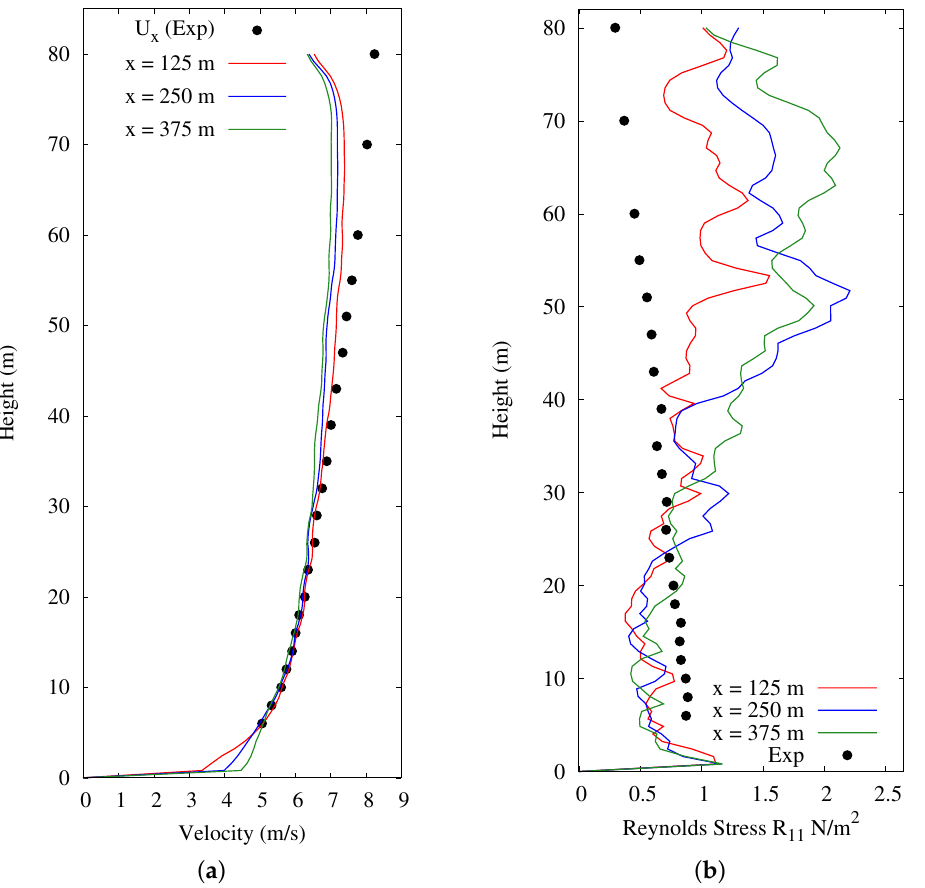
Figure 12. Development of the vertical profiles of ( a ) velocity, and ( b ) Reynolds stress R 11 at four different locations along the domain in x-direction. Colored lines are the simulation results and time-averaged over 400 s. Black dots are values set at the inlet, derived from atmospheric boundary layer wind tunnel experiments